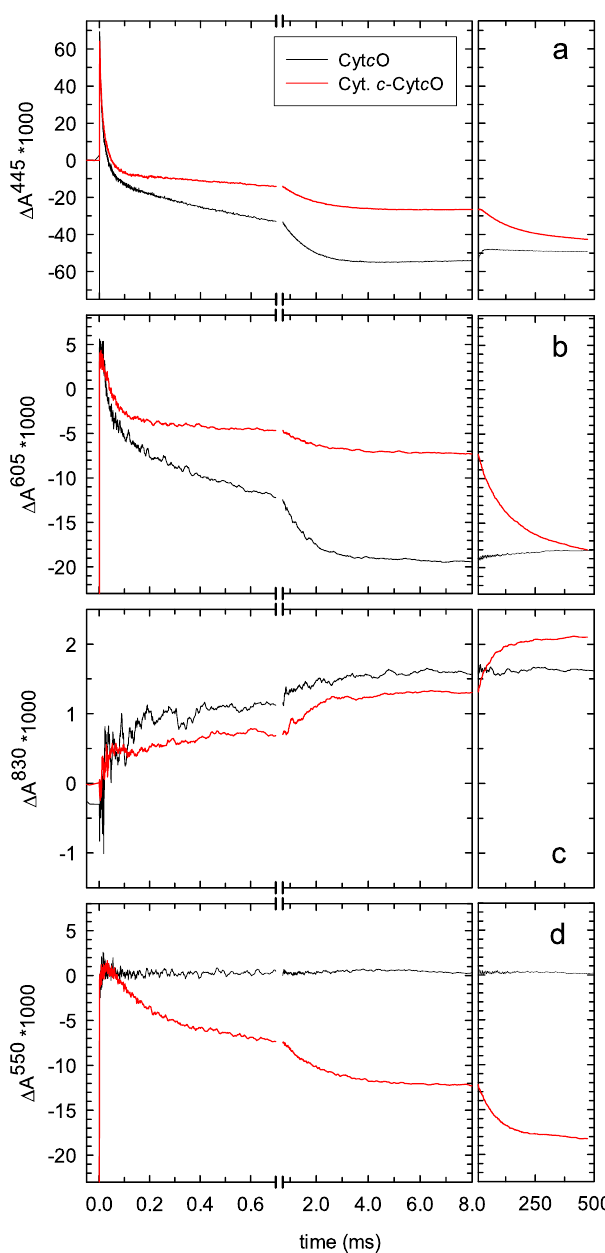
Figure 3. Kinetics of absorbance changes upon reaction with O 2 . The four-electron reduced Cyt c O (black traces) or the five-electron-reduced cyt. c -Cyt c O complex (red traces) was mixed with an O 2 -saturated buffer solution. About 200 ms after mixing with the O 2 -containing buffer, at time = 0, the CO-ligand was removed by a laser flash. The four-electron complex becomes oxidized over a time scale of 8 ms (left-hand side boxes). At 445 nm ( a ) the main contribution is from redox changes at hemes a and a 3 . At 605 nm ( b ) the main contribution is from redox changes at heme a (80%) and the remaining fraction originates from changes at heme a 3 . At 830 nm ( c ) the main contribution is from Cu A where an increase in absorbance is associated with oxidation. At 550 nm ( d ) the main contribution is from redox changes at cyt. c . At 445 nm and 605 nm, the rapid change in absorbance at t = 0 is associated with CO dissociation. It is followed in time by a decrease in absorbance associated with binding of O 2 ( τ ≅ 10 μ s), formation of the P R state ( τ ≅ 40 μ s) and oxidation of the Cyt c O ( τ ≅ 1.5 ms). The P R → F reaction is not seen at these wavelengths. At 830 nm two components are seen with time constants of 200 µ s ( P R → F ) and 1.5 ms ( F → O ). Oxidation of cyt. c occurs over the same time scale. In the presence of cyt. c absorbance changes attributed to the Cyt c O (panels a–c) were smaller because the redox sites were re-reduced by cyt. c during the course of the reaction. Over a time scale of ~500 ms (right-hand side boxes) all redox sites become oxidized. The small increase in absorbance over this time scale in the absence of cyt. c is due to small fractional re-reduction of Cyt c O by ascorbate. Experimental conditions after mixing: 1.1 μ M Cyt c O, 20 mM HEPES at pH 7.5, 0.05% DDM, 100 μ M EDTA, 2 mM ascorbate, 1 μ M hexa-ammine- ruthenium(II) chloride, 1 mM O 2 at ~22 °C (black trace). The red traces are averages of three traces